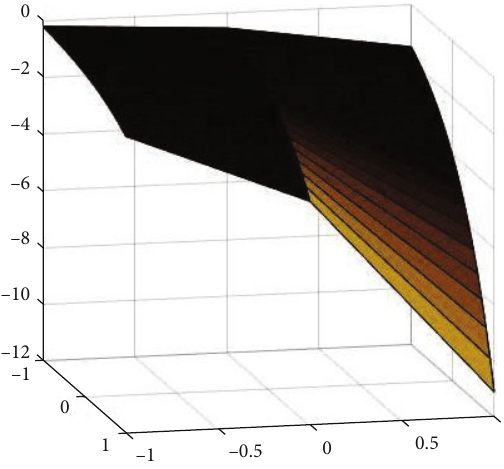
Figure 9: (a) Actual and (b) SDM/q-HATM result of ν ð χ , ξ , I Þ at δ = 1